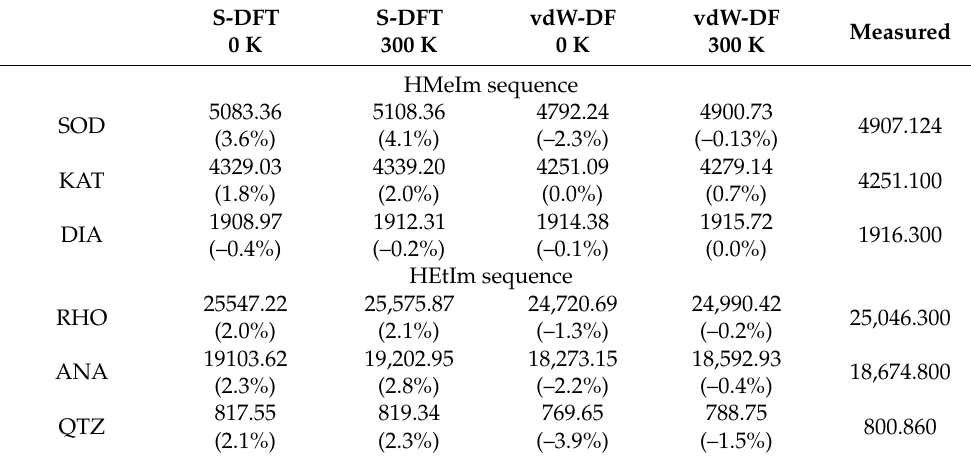
Table 1. Volume of the unit cells in Å 3 for S-DFT and vdW-DF, with the BH functional [20], at 0 K and 300 K. The measured values are from [15]. Numbers in parentheses represent the relative deviation with respect to measurements.